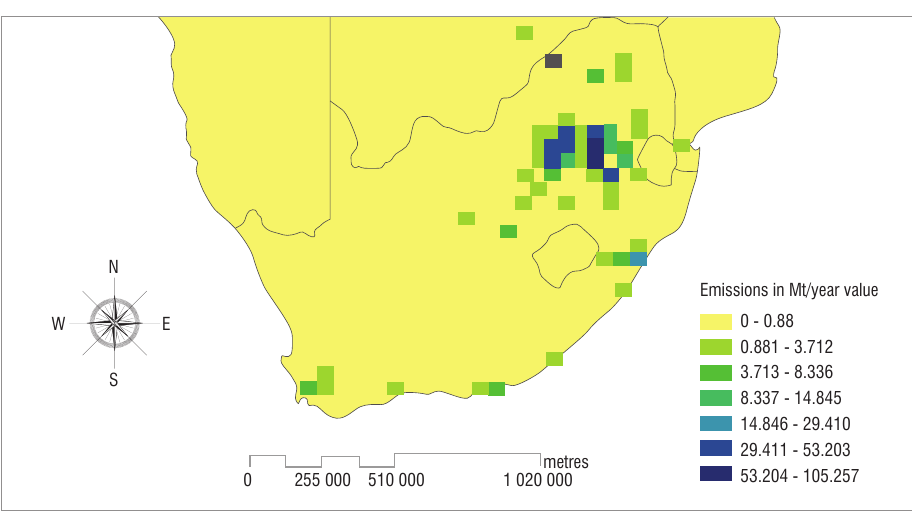
Figure 1: Main CO